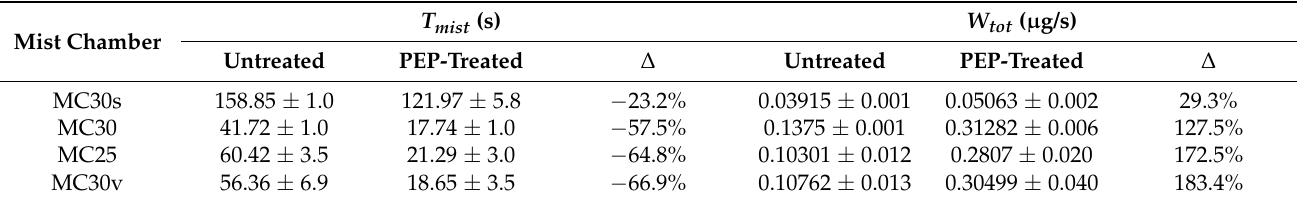
Table 1. Mist-out time and misted mass transport rate for MC chambers, untreated and after PEP, for pump speed S50. T mist (s) W tot ( µ g/s) Mist Chamber